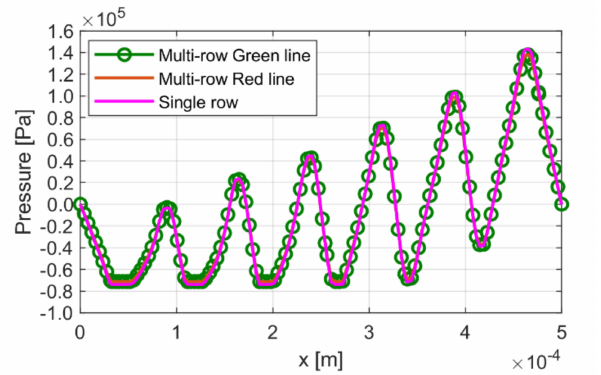
Figure 14. Pressure profiles of a full texturing surface with dimples side 50 µ m and gap 5 µ m, sliding velocity 5 m / s. Comparison between a single-row configuration and a multi-row.